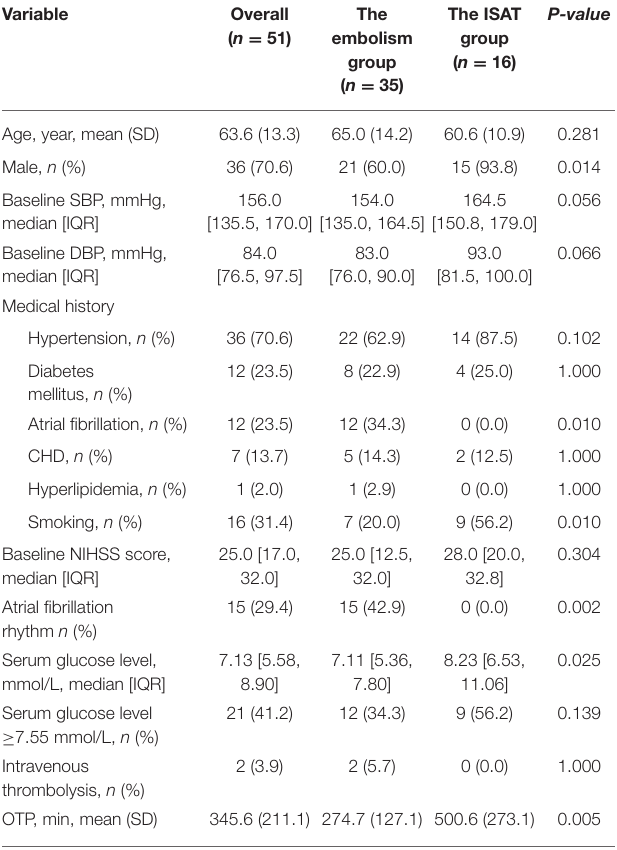
TABLE 4 | The characteristics of the validation